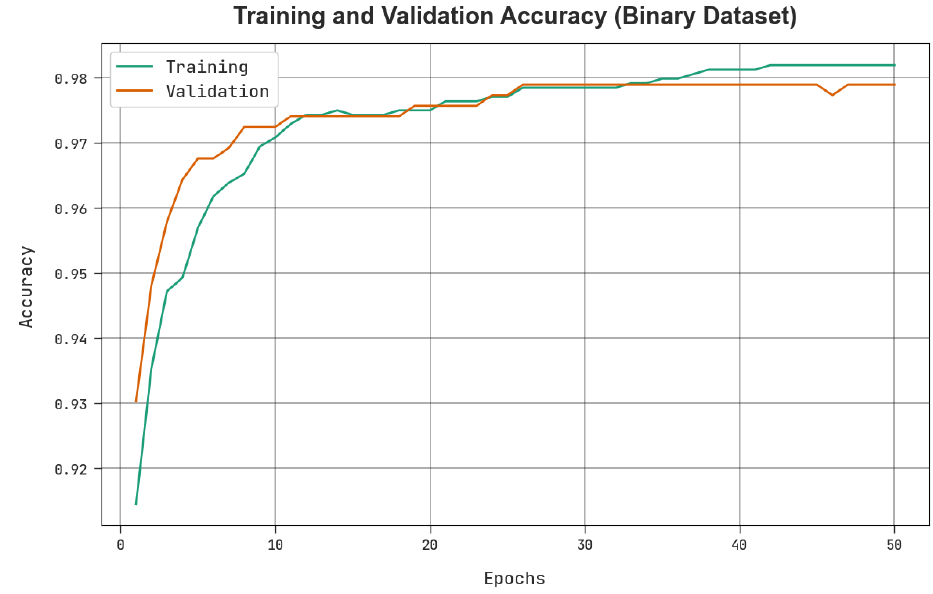
Figure 5. Accuracy curve of the H3SC-DLIDS approach on a binary dataset.